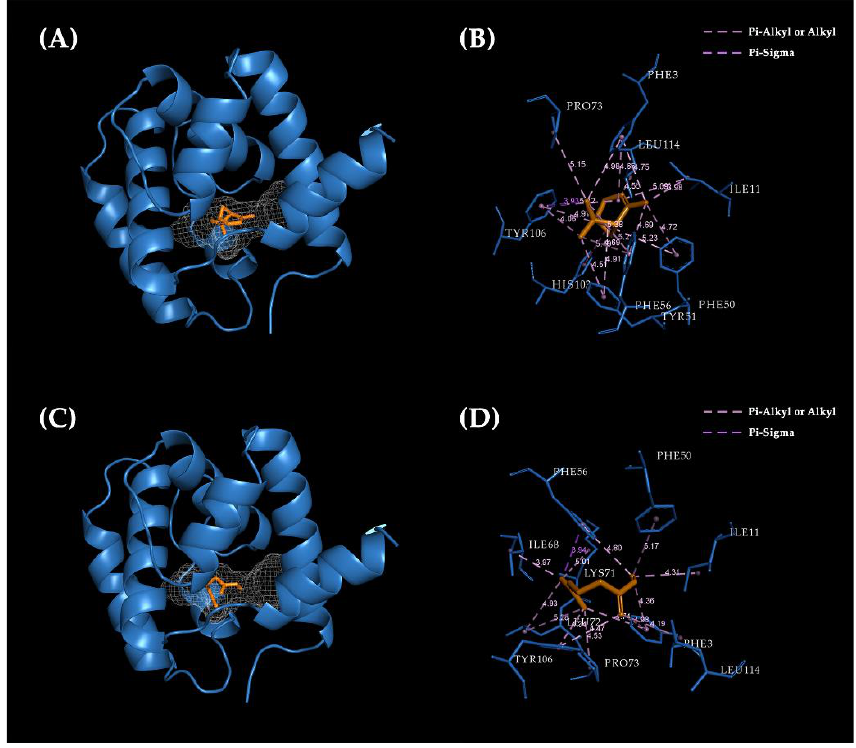
Figure 7. Molecular docking of EparOBP2 with α -pinene and myrcene. ( A ) 3D structure of EparOBP2 with α -pinene. ( B ) 3D predicted interaction view of EparOBP2 with α -pinene. ( C ) 3D structure of EparOBP2 with myrcene. ( D ) 3D predicted interaction view of EparOBP2 with myrcene. The binding pocket was marked by meshes.